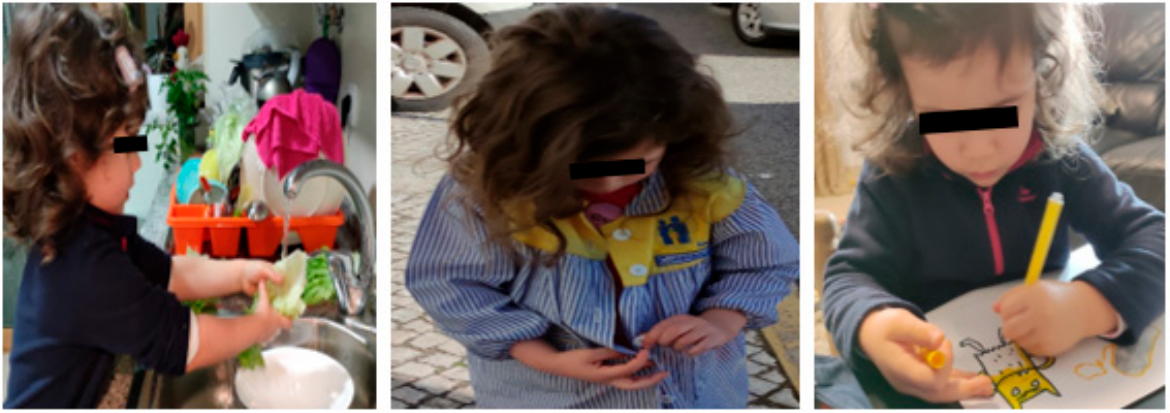
Figure 14. Personal autonomy.